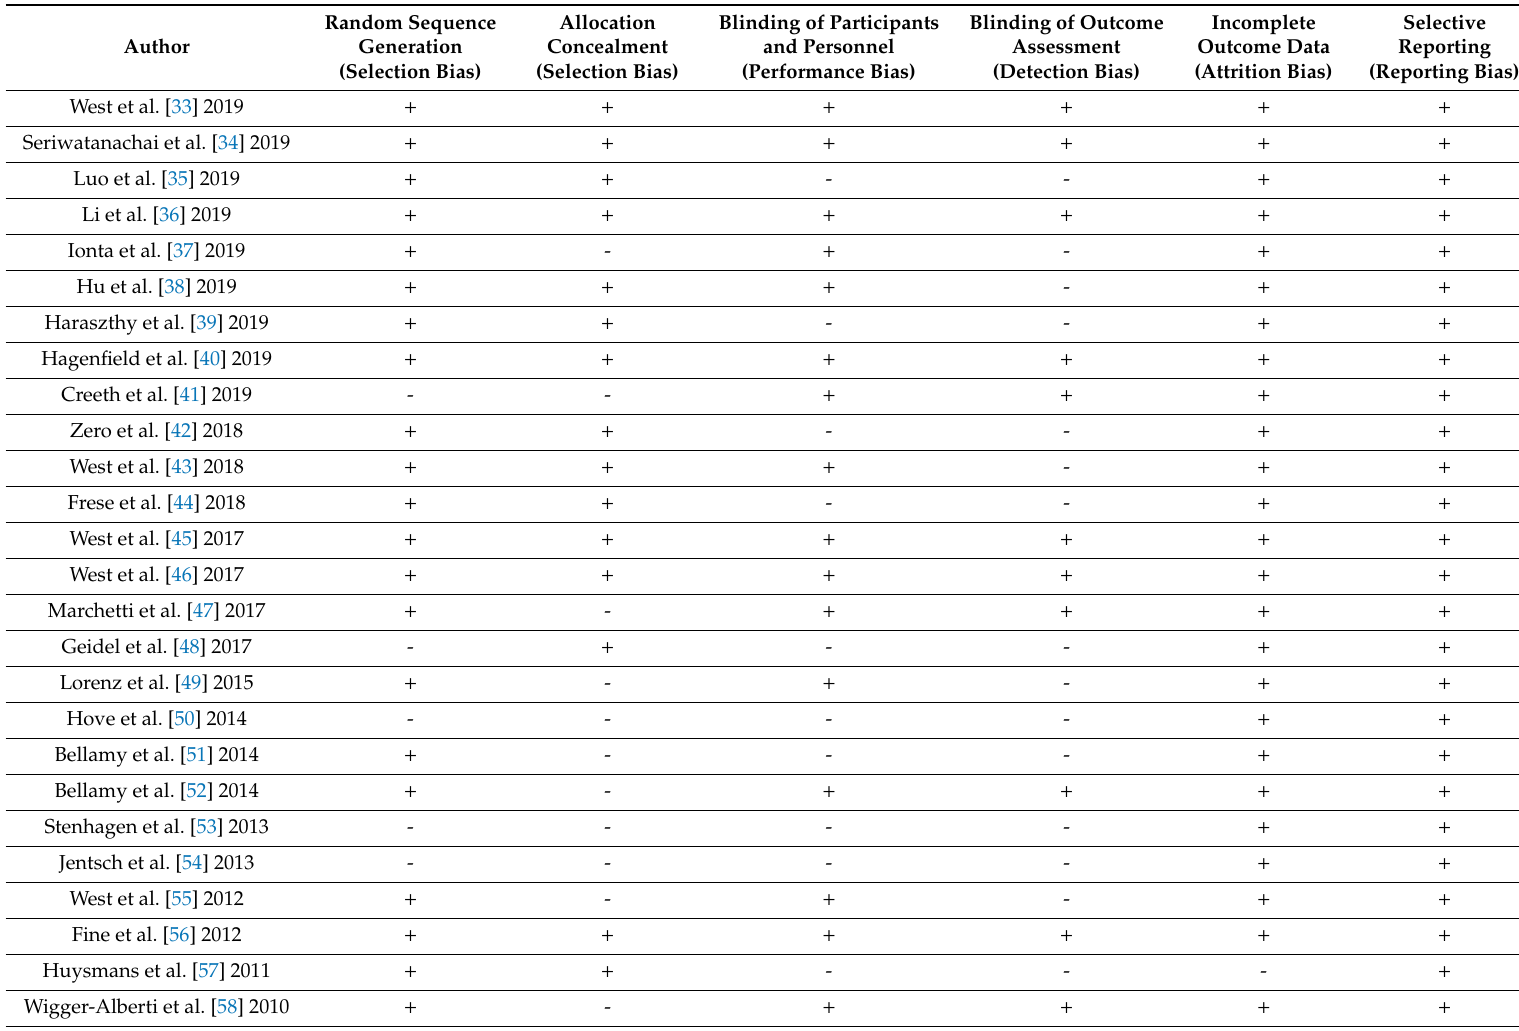
Table 2. Risk of bias analysis according to PRISMA, as specified in paragraph risk of bias (“ + ”: low risk of bias; “-“: high risk of bias; “?”: unclear risk of